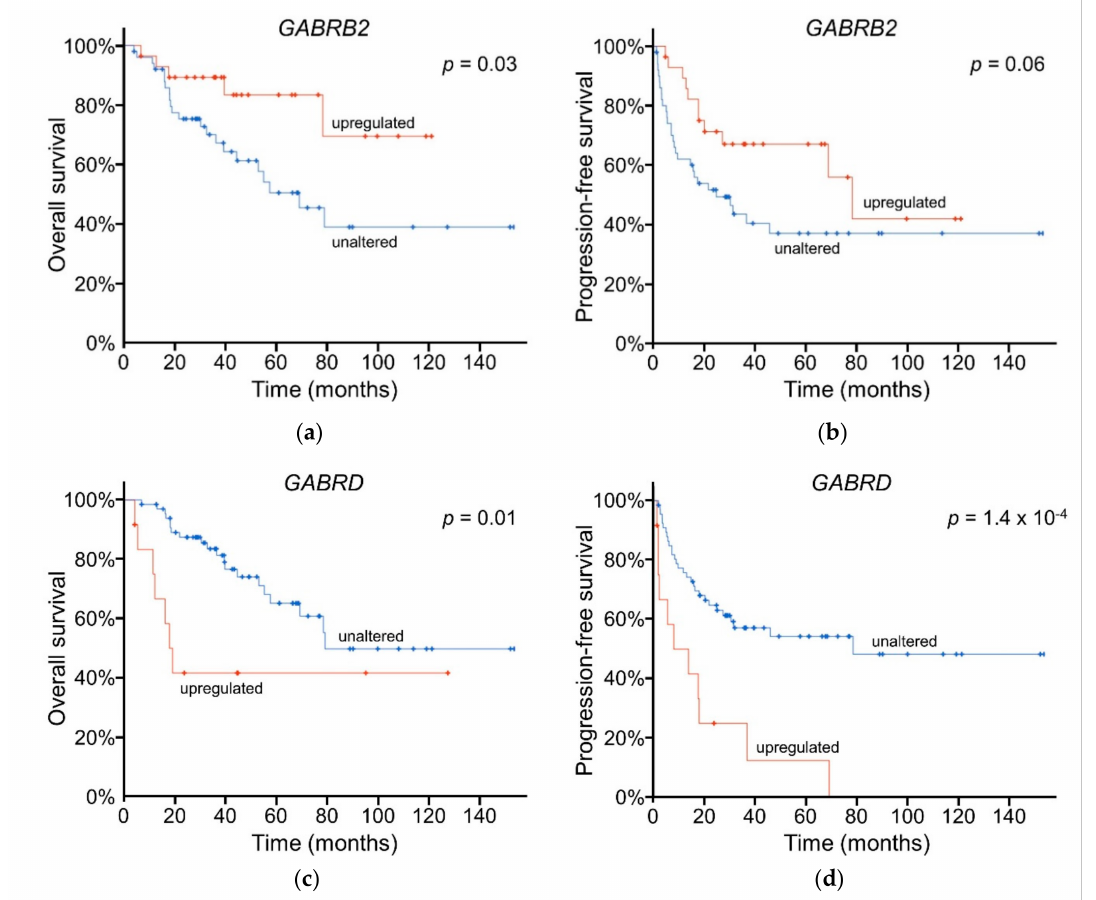
Figure 6. Kaplan-Meier survival estimates of patients with upregulated vs unaltered tumoral GABRB2 or GABRD transcript expression. ( a ) overall survival and ( b ) progression-free survival in samples with upregulated GABRB2 expression ( n = 28) vs unaltered ( n = 50). ( c ) overall survival and ( d ) progression-free survival in patients with tumors expressing upregulated GABRD transcripts ( n = 12) vs unaltered ( n = 66). Log-rank tests. Plots generated by cBioPortal,